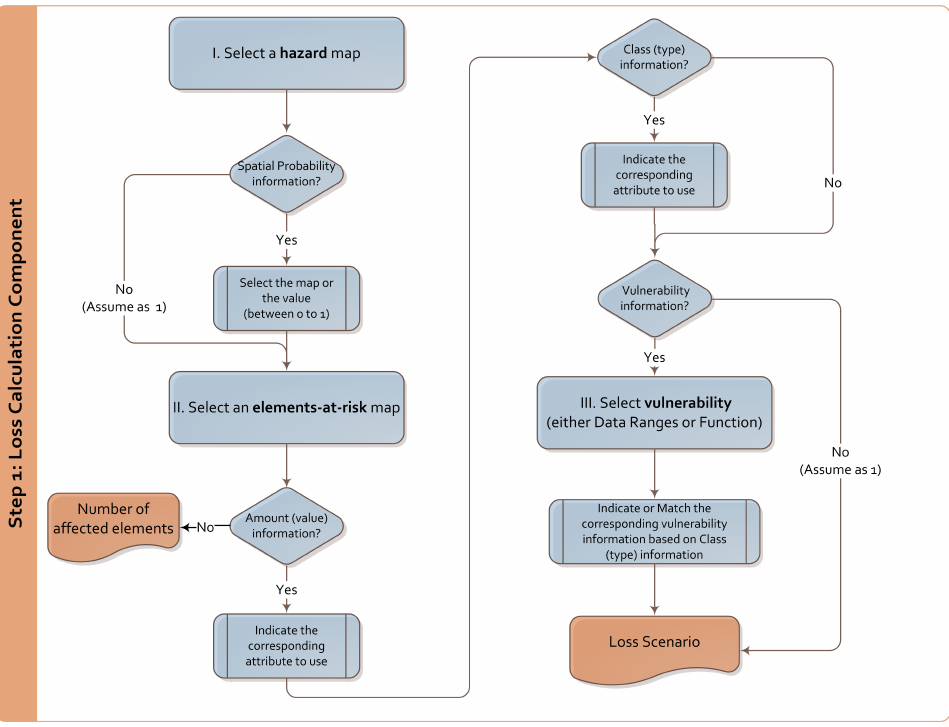
Figure 5. Workflow of the loss calculation component, illustrating the three main types of input information (hazard, elements at risk and vulnerability) with additional parameters for the generation of loss scenarios. For example, if the buildings (as elements at risk) have no amount (monetary) information, only the affected number of buildings can be